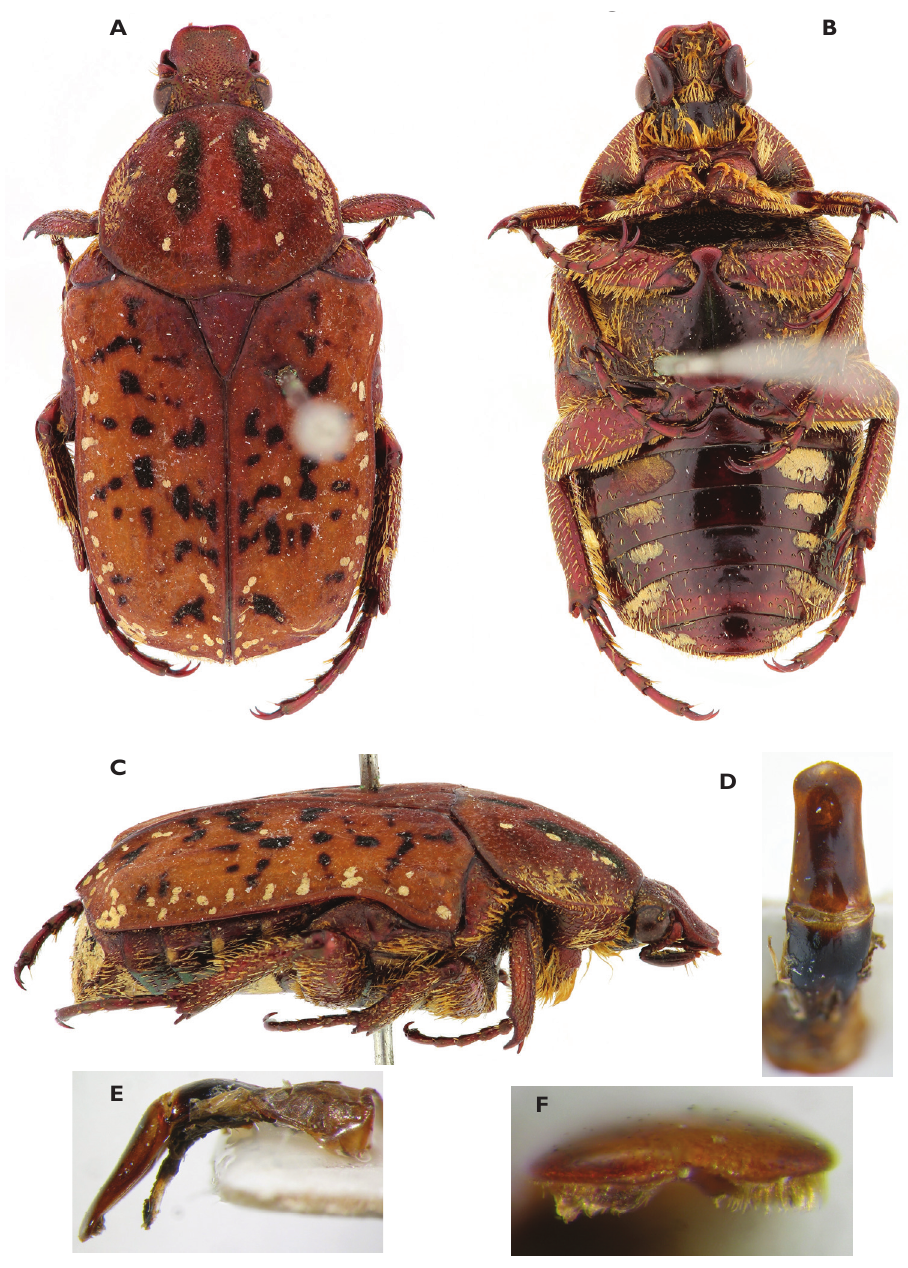
Figure 15. Atrichelaphinis ( Eugeaphinis ) simillima (Ancey, 1883), "compared to type" by Bourgoin (IRSN). A Dorsal view B ventral view C lateral view D parameres in dorsal view E parameres in lateral view F apex of